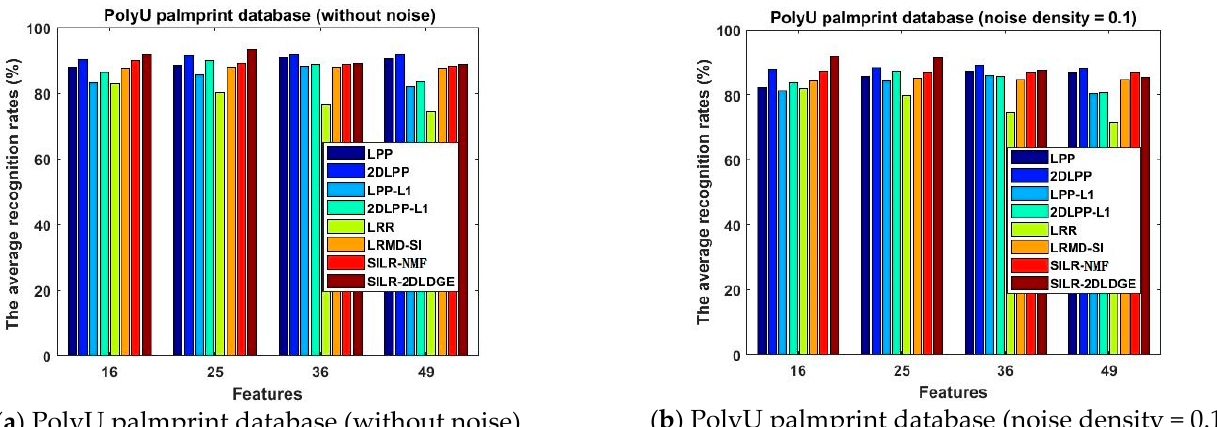
Figure 9. The average recognition rates (%) of the eight algorithms in the PolyU palmprint database vary with the dimension.